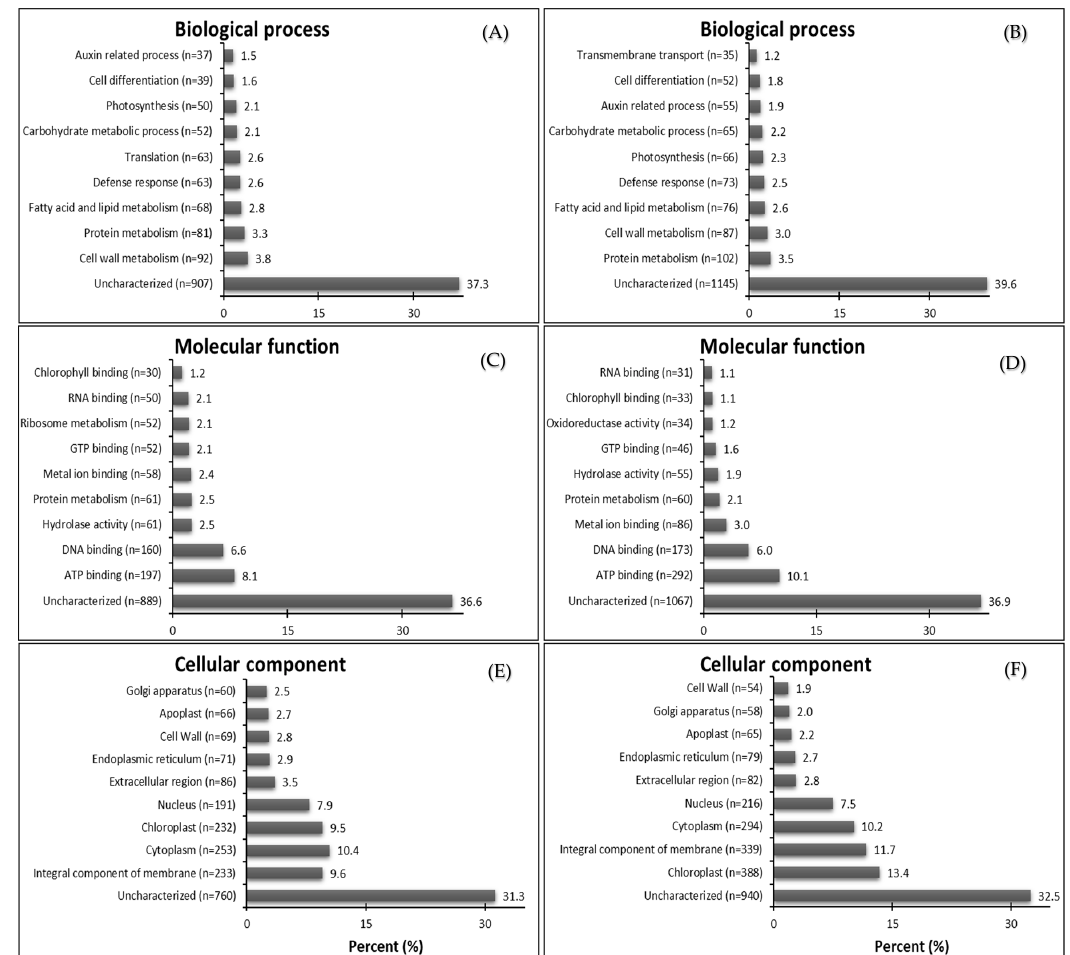
Figure 3. Summary of top ten gene ontology (GO) terms identified as down-regulated genes (DEGs-down) in glyphosate-resistant and -sensitive C. bonariensis biotypes. Annotated sequences were classified into the biological process, molecular function, and cellular component. ( A , C , and E ) GR — down-regulated DEGs, n = 2,333; ( B , D , and F ) GS — down-regulated DEGs, n = 2,800.